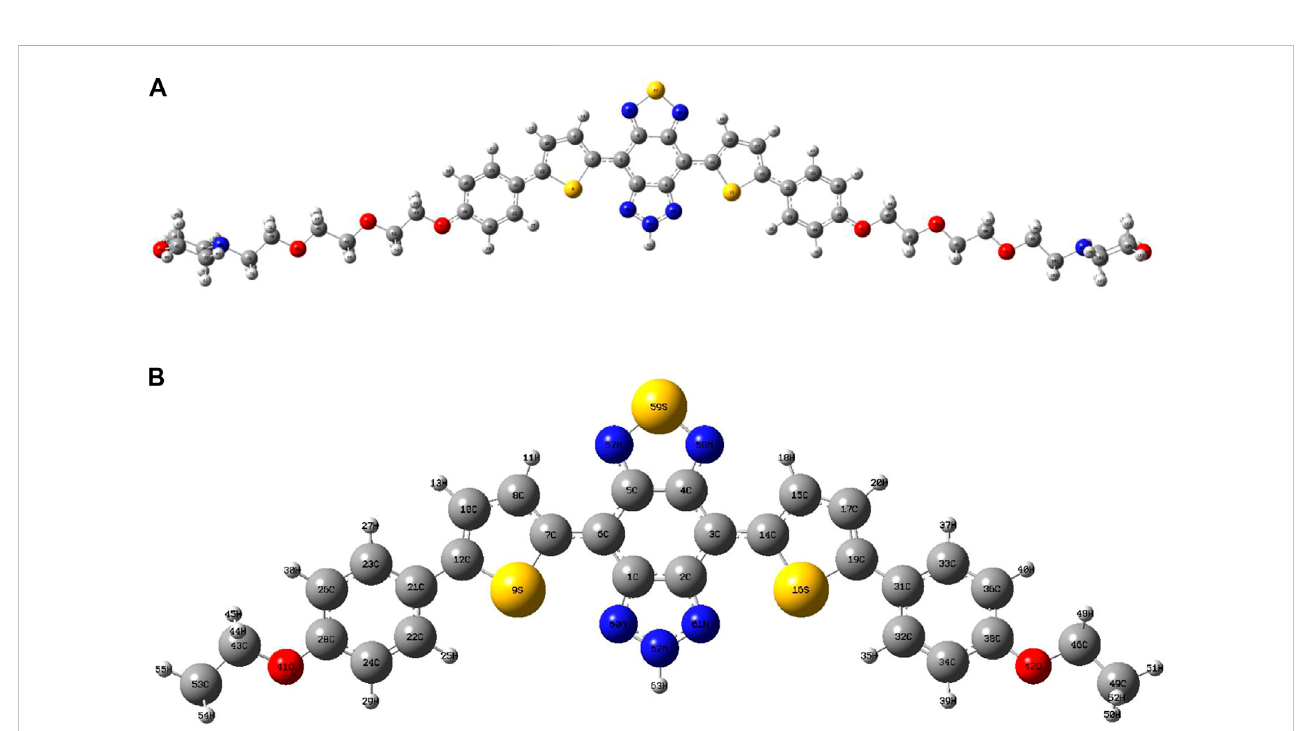
FIGURE 2 Optimized structures of (A) LS-TZ and (B)